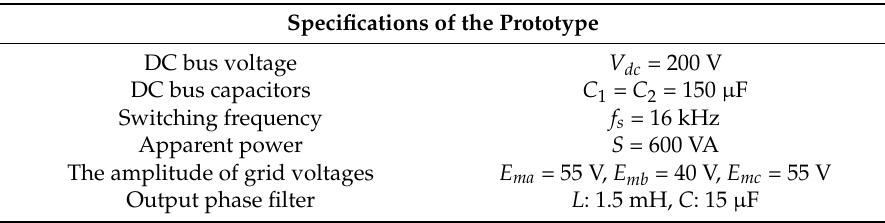
Table 2. Specifications of the prototype for simulation.